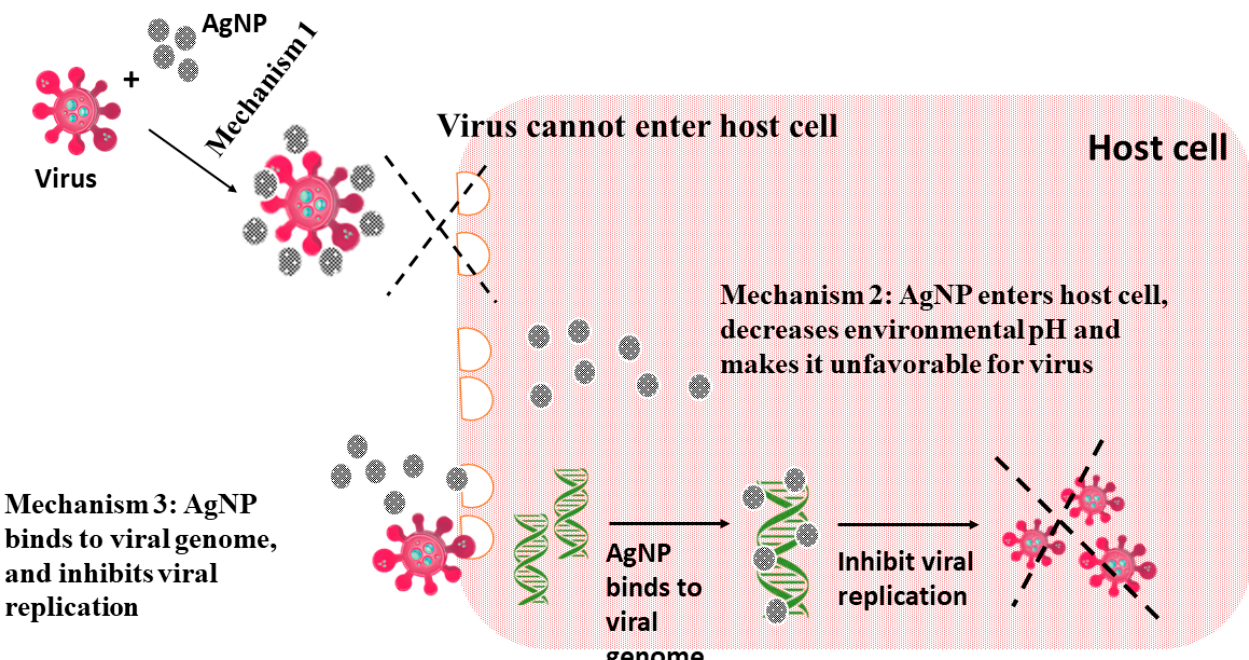
Figure 6. The figure depicts various hypothetical mechanisms, namely inhibition of viral entry, decrease in environmental pH in host cell, and inhibition of viral replication in host cell. These mechanisms indicate antiviral activity of AgNPs.